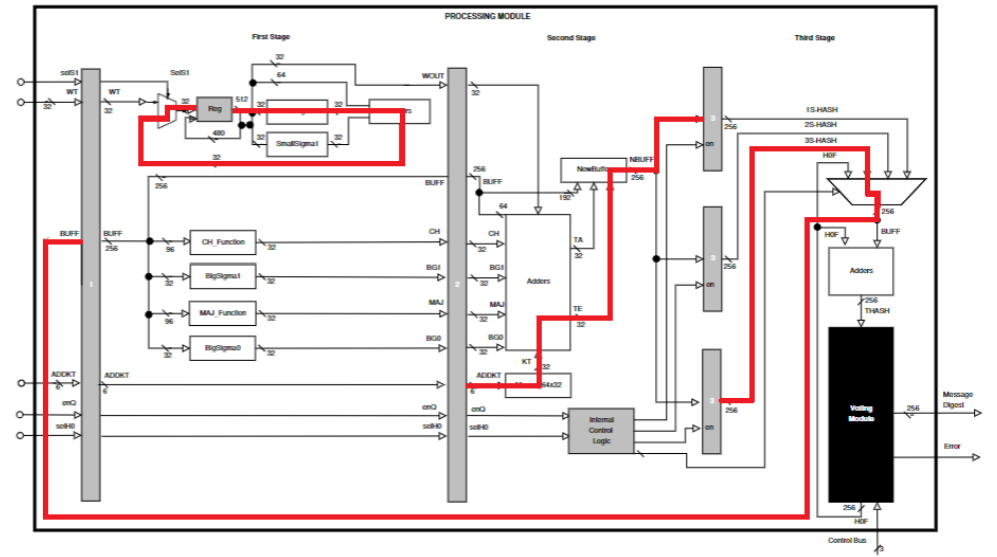
Figure 13. Critical paths in the architecture for each pipeline stage. Red lines indicate a path where hardware resources appear for both place and route